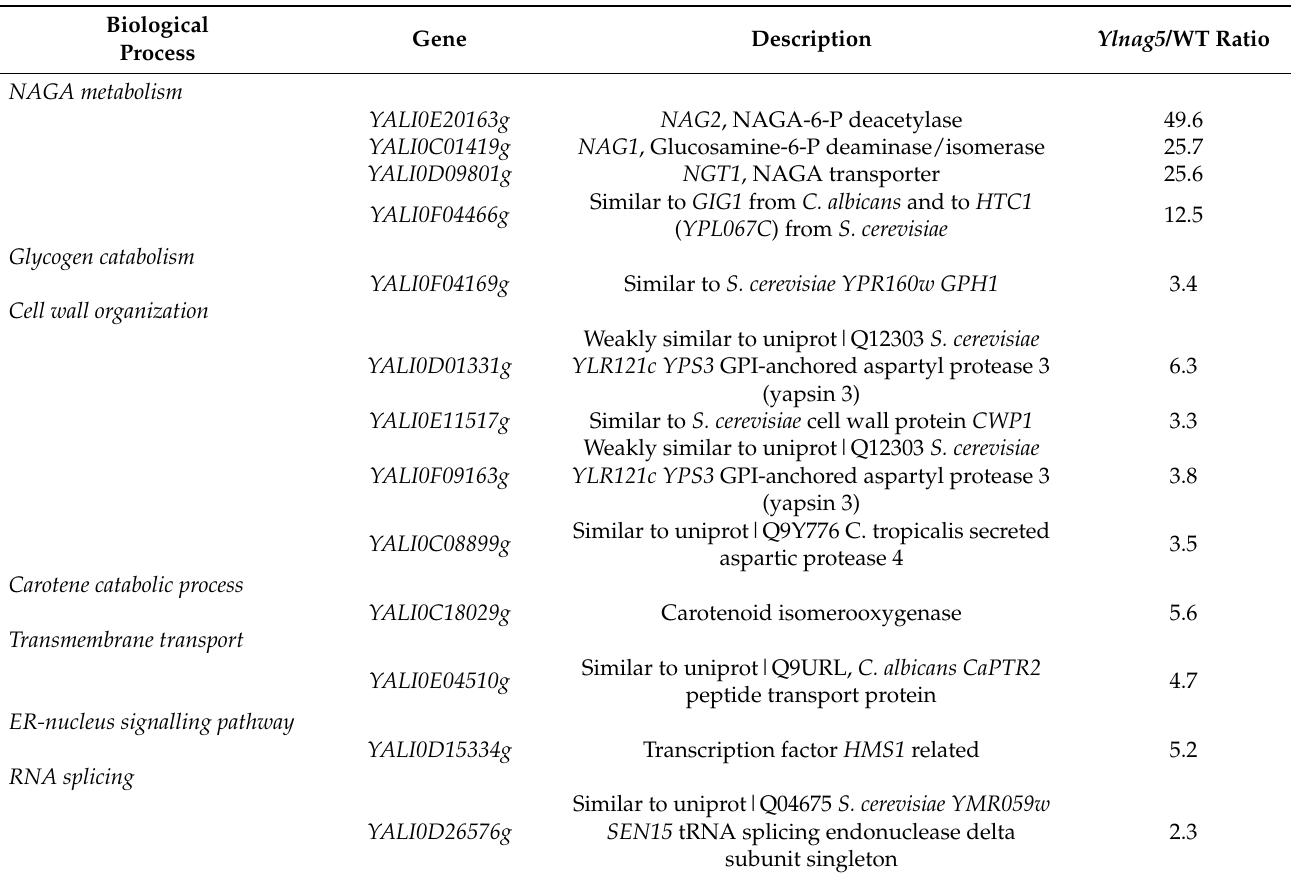
Table 2. Gene ontology enrichment analysis performed with the genes overexpressed in the Ylnag5 mutant vs wild type.